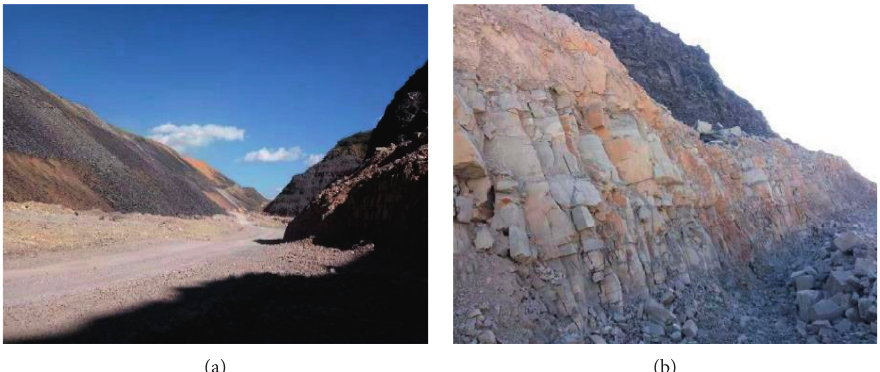
Figure 2: The mining status of Jinning Phosphate Mine no. 2 pit. (a) Current status of surface mining. (b) Development of fissures in open- pit mining at this